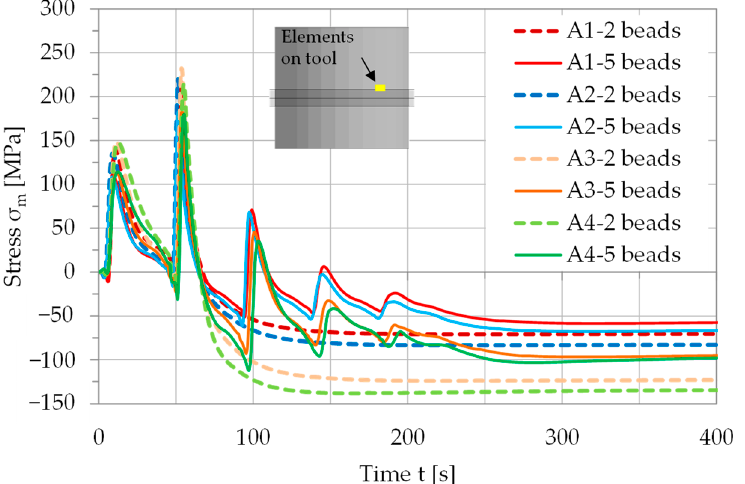
Figure 20. Comparison of the stress history of the tool element with two and five parallel weld-beads of different dimensions (A1–A4).